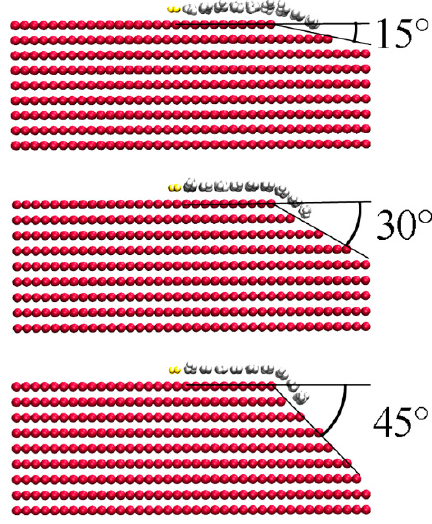
Figure 2. The structure of a piece of graphene sheet consisting of 290 C atoms on different slopes of the grain boundary after 200 ps relaxation at 1200 K.